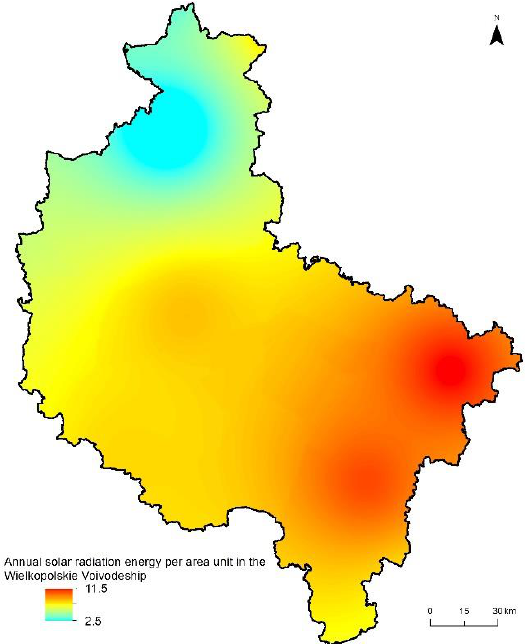
Figure 9. Annual solar radiation energy per area unit in the Greater Poland Voivodeship (own calculations).